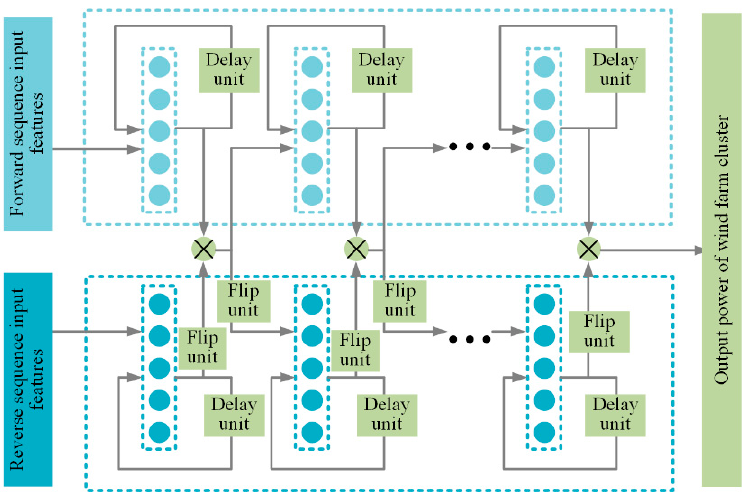
Figure 6. Prediction flowchart of BLSTM neural network.